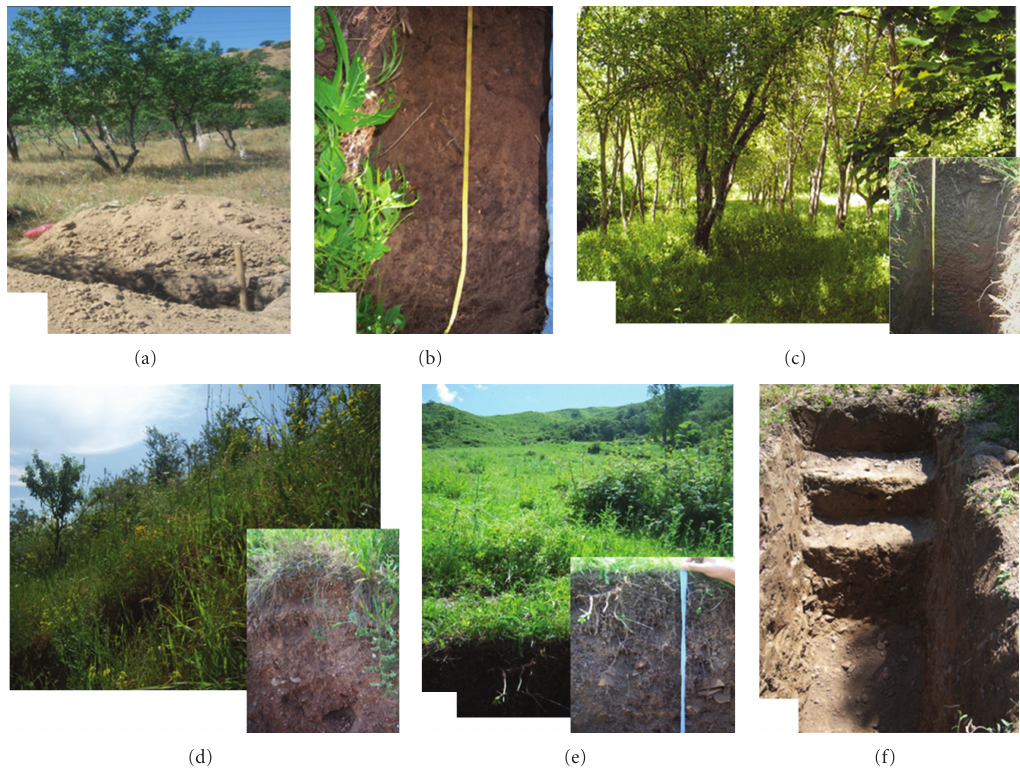
Figure 2: Representative landscape and soil profile pictures of the Kukart watershed including forest sites (a–c), pasture (d-e), and cultivated (f) land use. The forest sites included Pistachio plantation located at the Suzak (Su 1 ) site under a Sierozem (a) and two Walnut-fruit forests under a Brown soil (b) and a Black-brown soil (c) located at the Kara-Alma sites, KA 1 and KA 2 , respectively. Two of the pasture sites are shown under a Brown soil (d) in Kalmak Kyrchyn (KK 1 ) and a Meadow-steppe soil (e) in Kyzyl-Suu (KSu). The Maize cultivated profile at Taigara (Tai) under Sierozem is shown (f). Details regarding the sites are described in Table